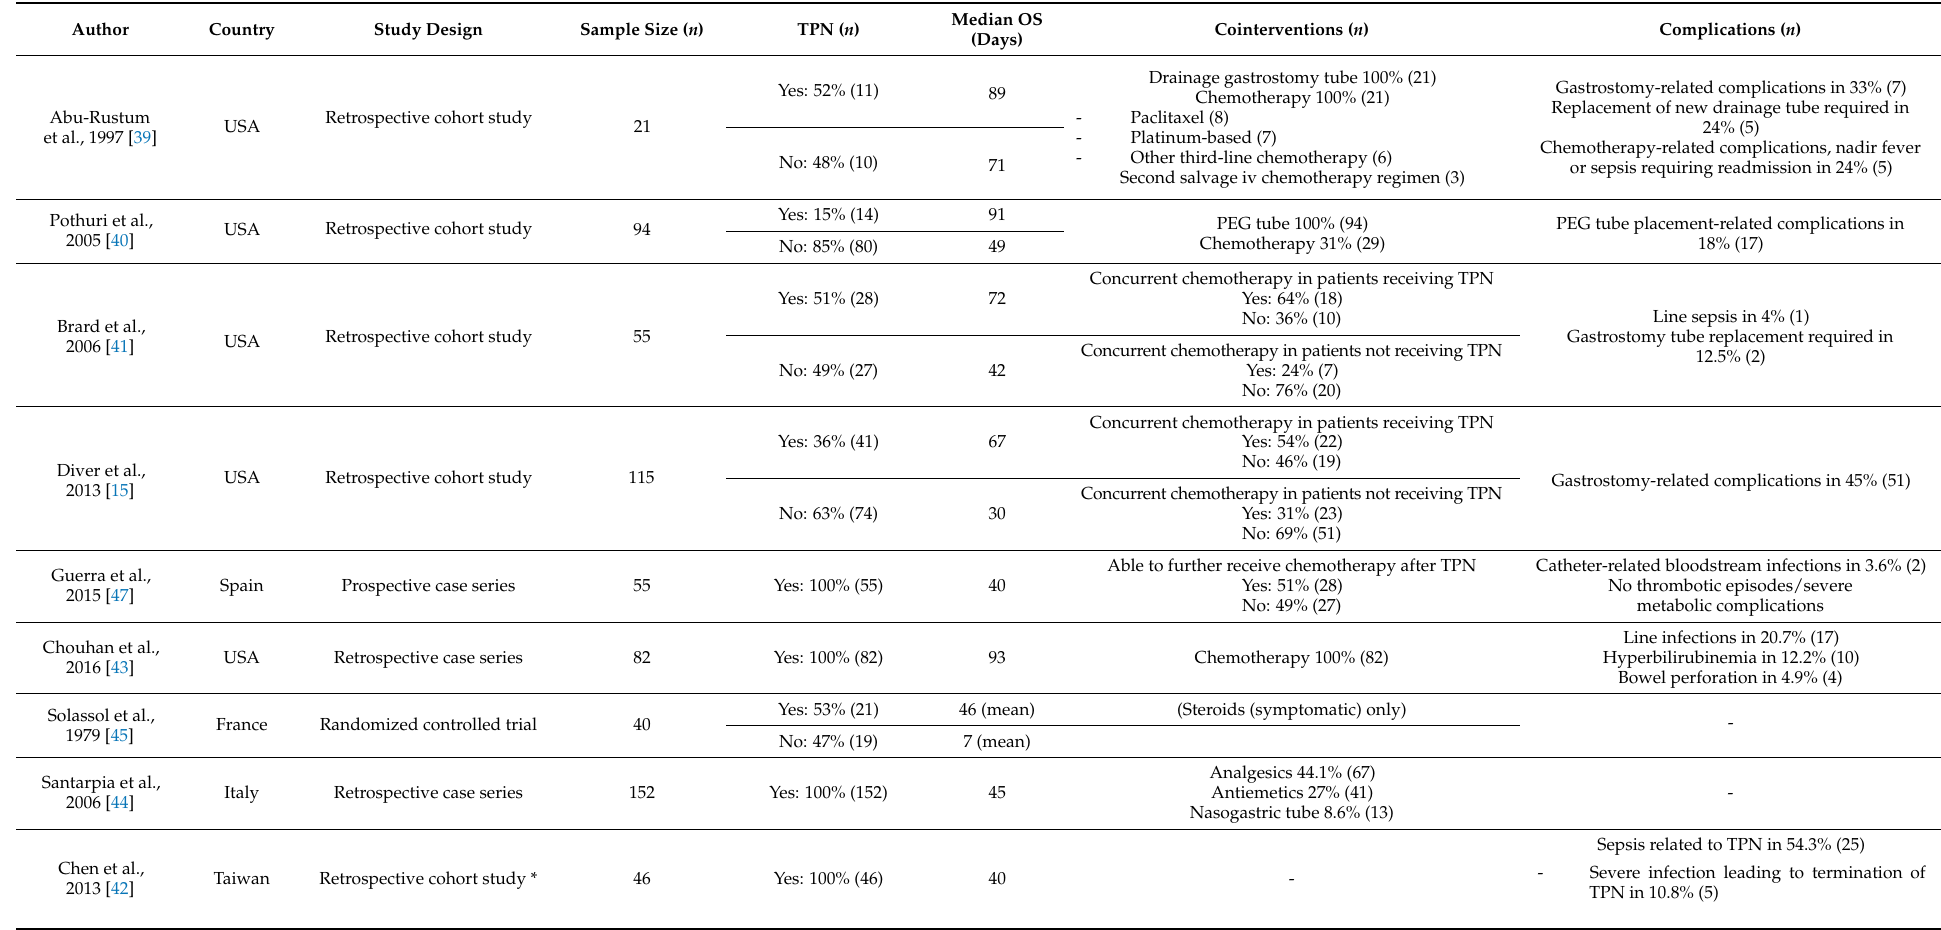
Table 1. Characteristics of all included studies ( n =